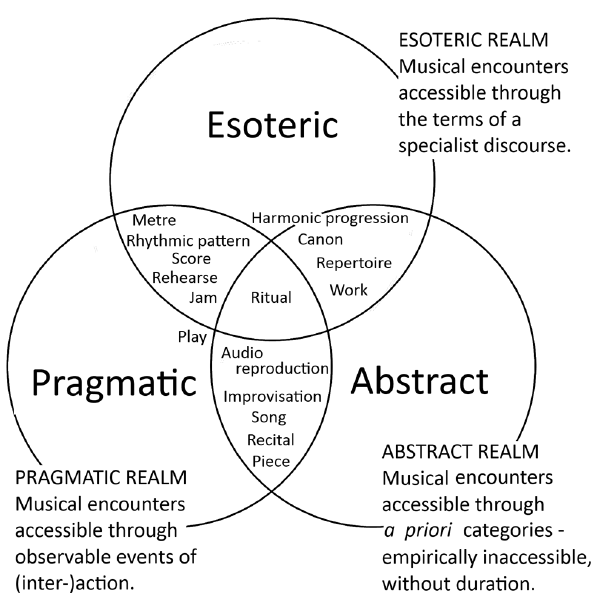
FIGURE 1 | Musical encounters and their experiential realms: pragmatic, esoteric, and abstract.